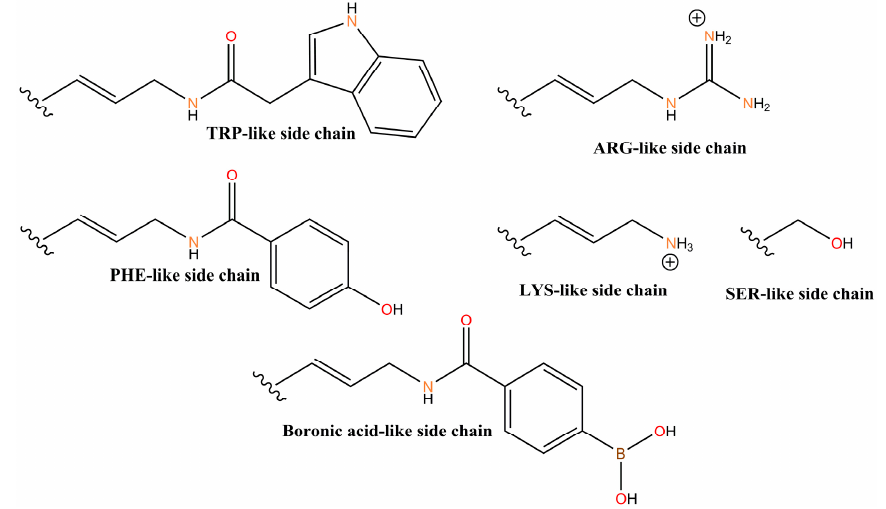
Figure 4. Example side chains (X) in 5-X-dU containing X-aptamer beads.